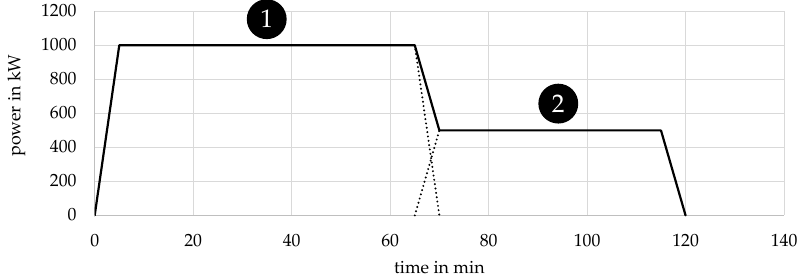
Figure 5. The load profile of the exemplary scheduling process.